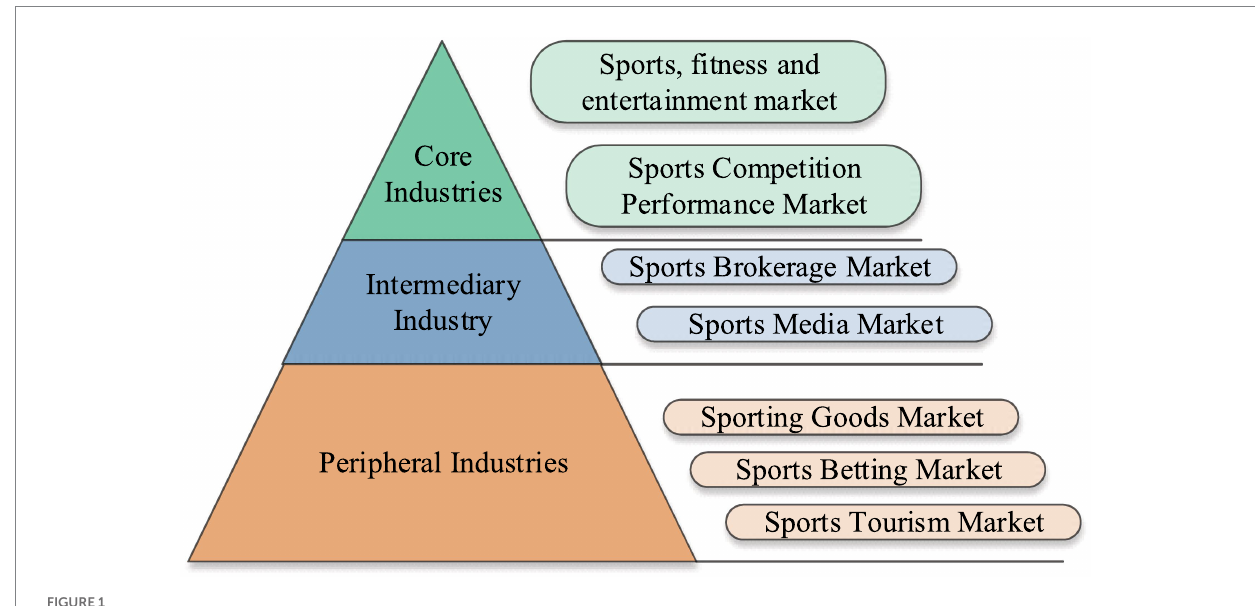
FIGURE 1 Classification of the sports